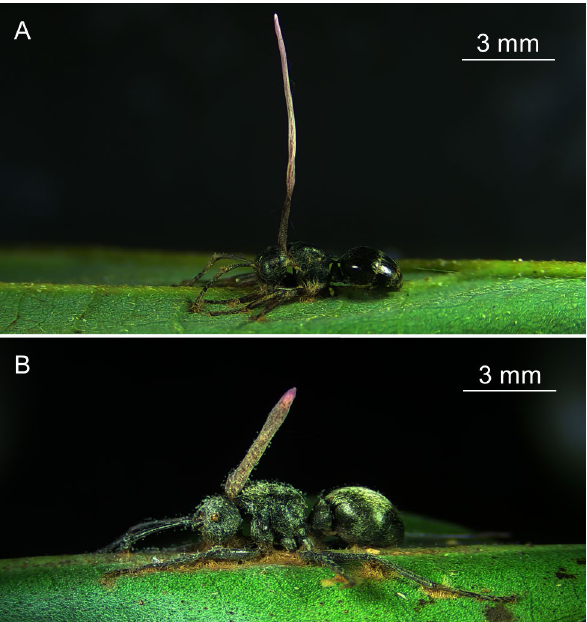
Figure 1. Ophiocordyceps unilateralis sensu lato-infected ( a ) Polyrhachis moesta and ( b ) P . wolfi , with the stroma growing from the ant cadaver. The specimens were collected from the Lianhuachi Research Center, Taiwan and photographed in the laboratory by Wei-Jiun